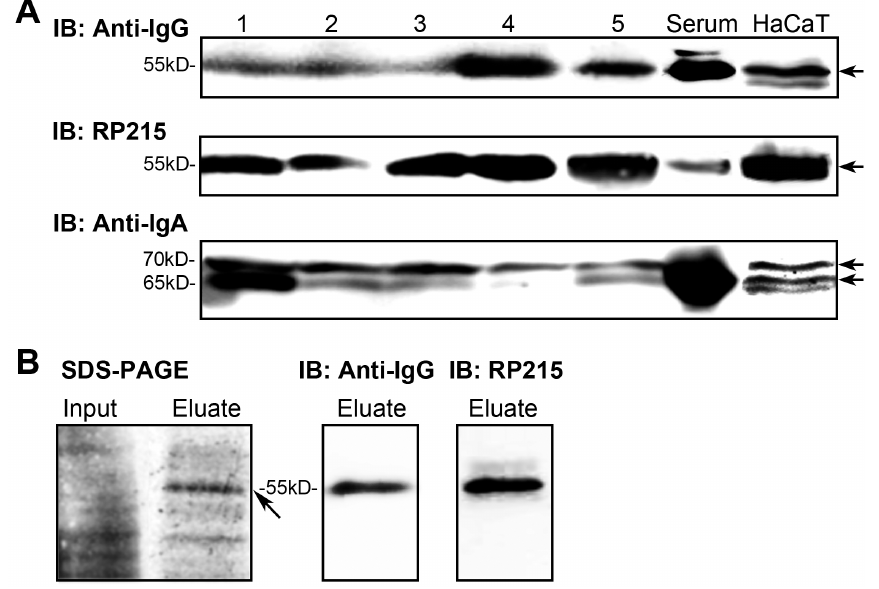
Figure 2. Expression of IgG and IgA in epidermal cells. ( A ) IgG or IgA expression in separated epidermal cells and HaCaT cell line determined by Western blotting using commercial anti-IgG antibody and RP215, or anti-IgA antibody, respectively. 1–5: epidermis samples. Arrows indicate immunoreactivity of IgG or IgA; ( B ) IgG purification by affinity chromatography with protein G sepharose. The protein band indicated by the arrow was further analyzed by mass